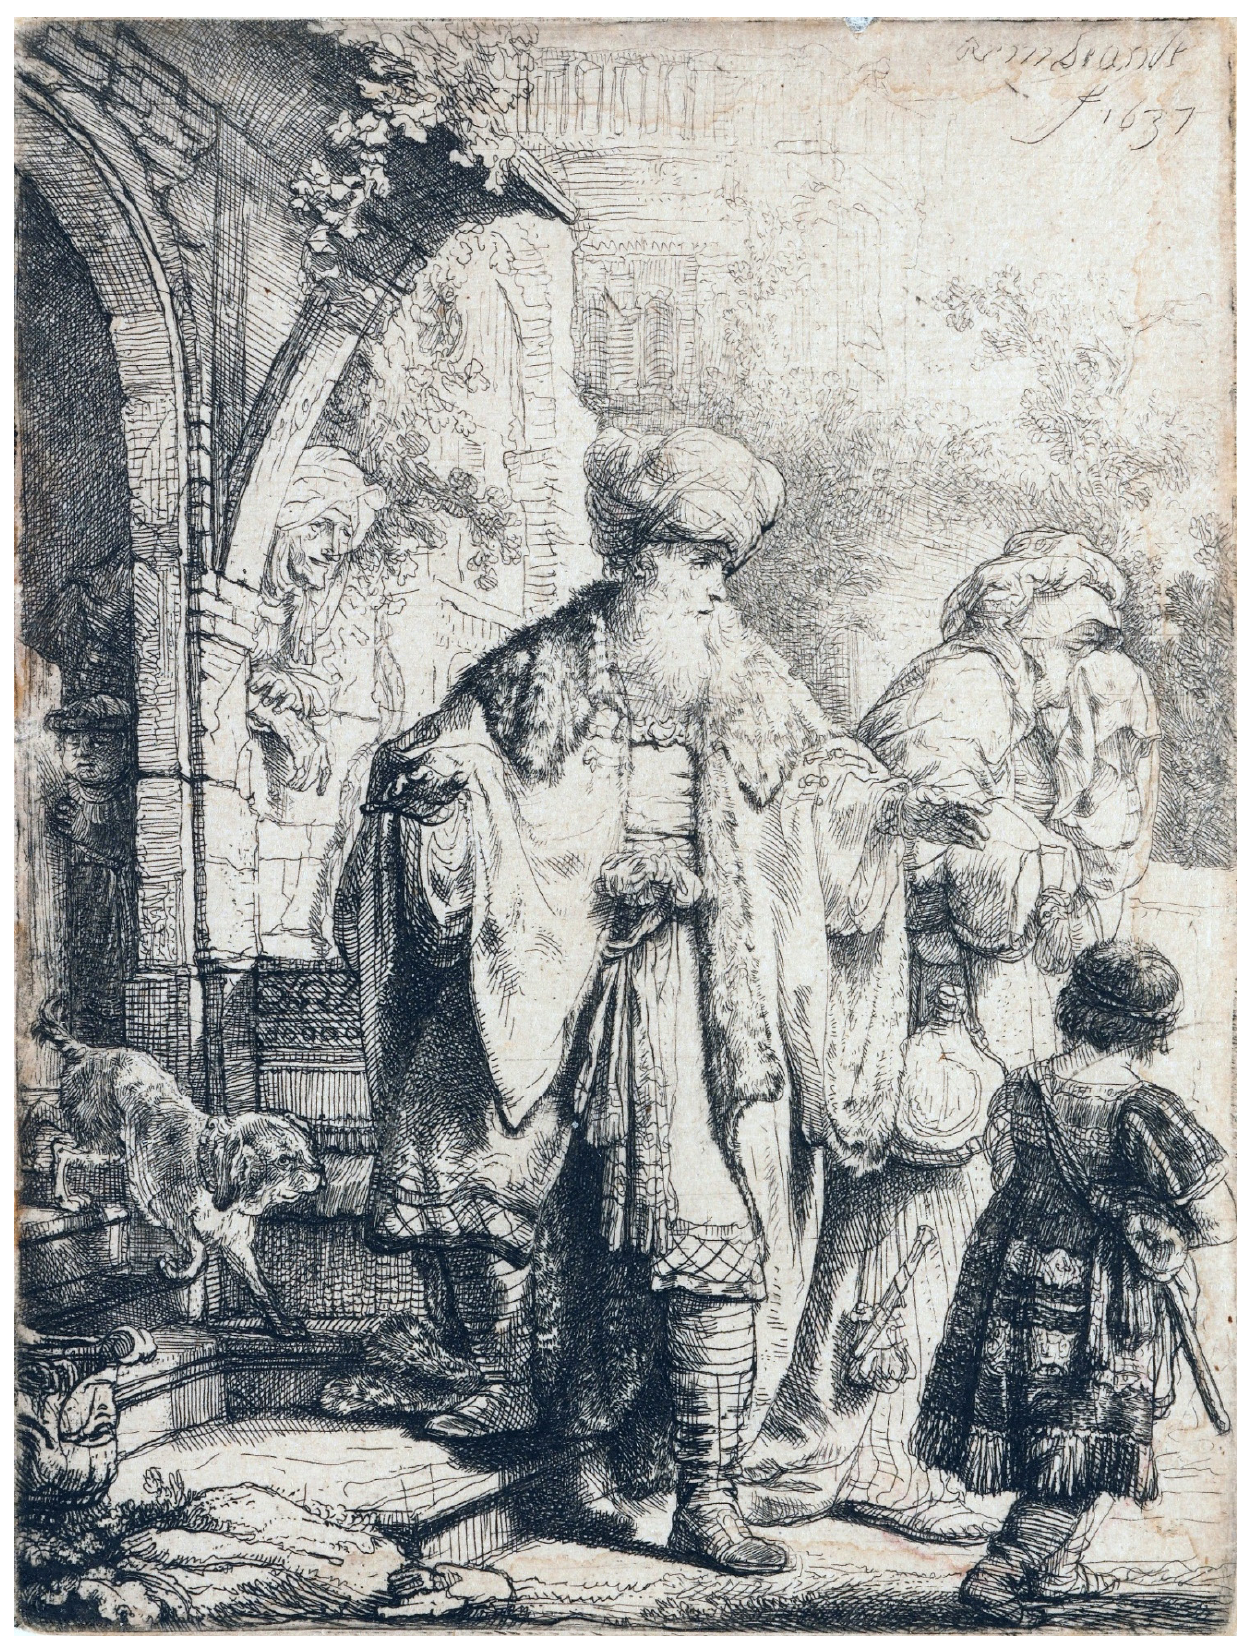
Figure 13. Rembrandt, 1637. Amsterdam, Rijksmuseum, RP-P-OB-56.